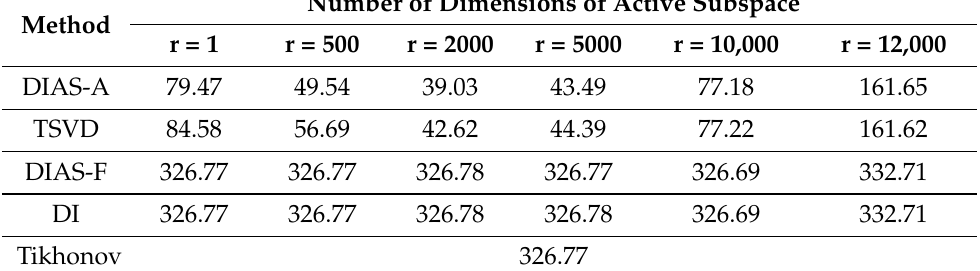
Table 9. Relative error (%) of inverse solutions by DIAS and Tikhonov regularization for underregu- larization case with α = 10 2 , noise level 5%.